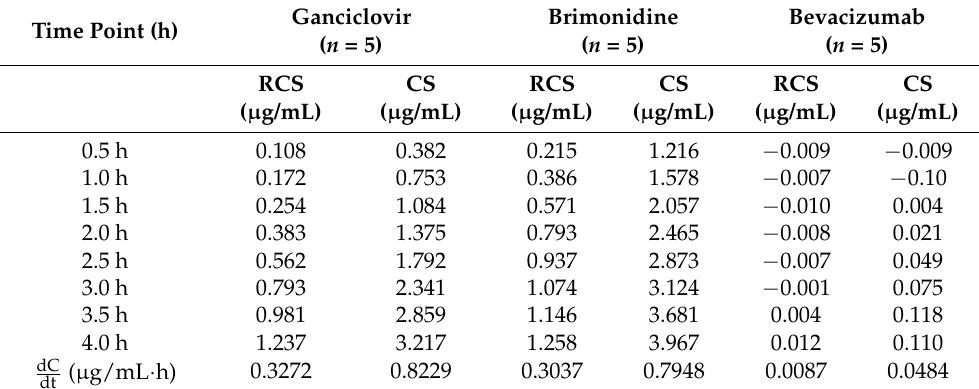
Table 1. Average time–concentration values and average change of drug concentration at the acceptor chamber.